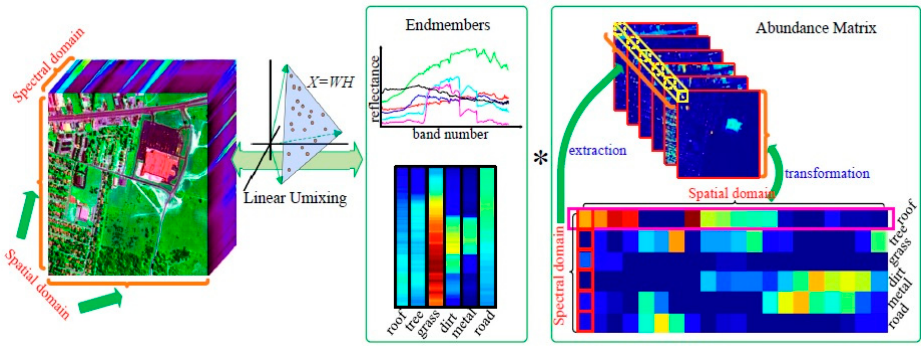
Figure 1. Illustration of the hyperspectral linear mixed model.